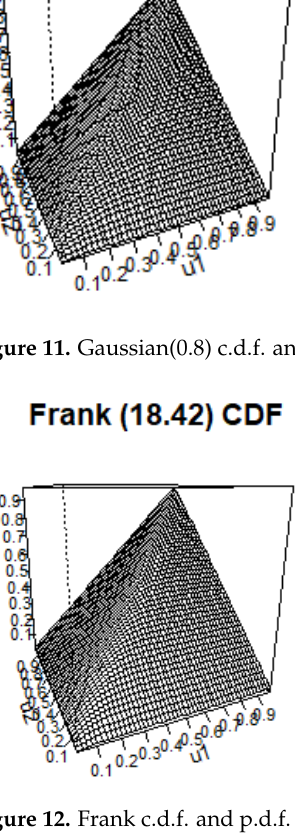
Figure 12. Frank c.d.f. and p.d.f. with α = 18.42.